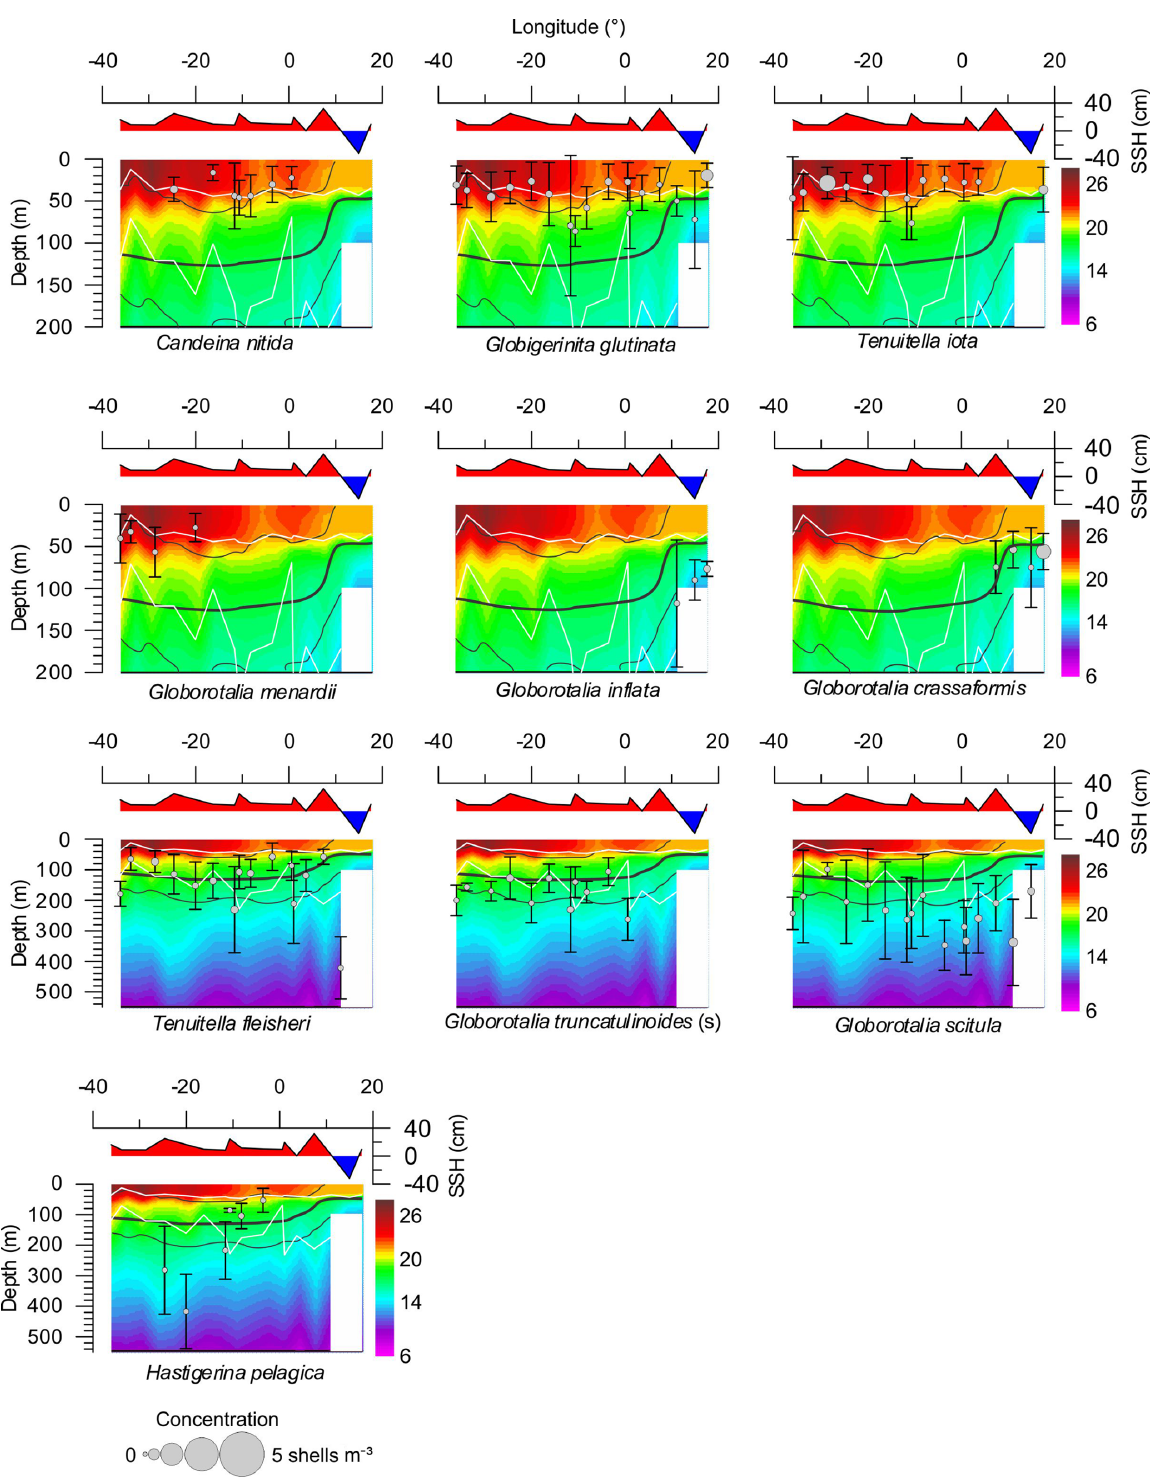
Figure 4. Variation of the depth habitat and standing stock (integrated over the upper 550m) of main species across the subtropical South Atlantic. Species data are compared with temperature (in ◦ C) (color filling). Chlorophyll a is shown with thin lines delimiting layers with 0.2mgm − 3 and a thick line indicating the chlorophyll a apex. Sea surface height (SSH) and boundaries of surface mixed layer and mixed and permanent thermocline layers are shown as continuous white lines. Note that the panels have varying depth